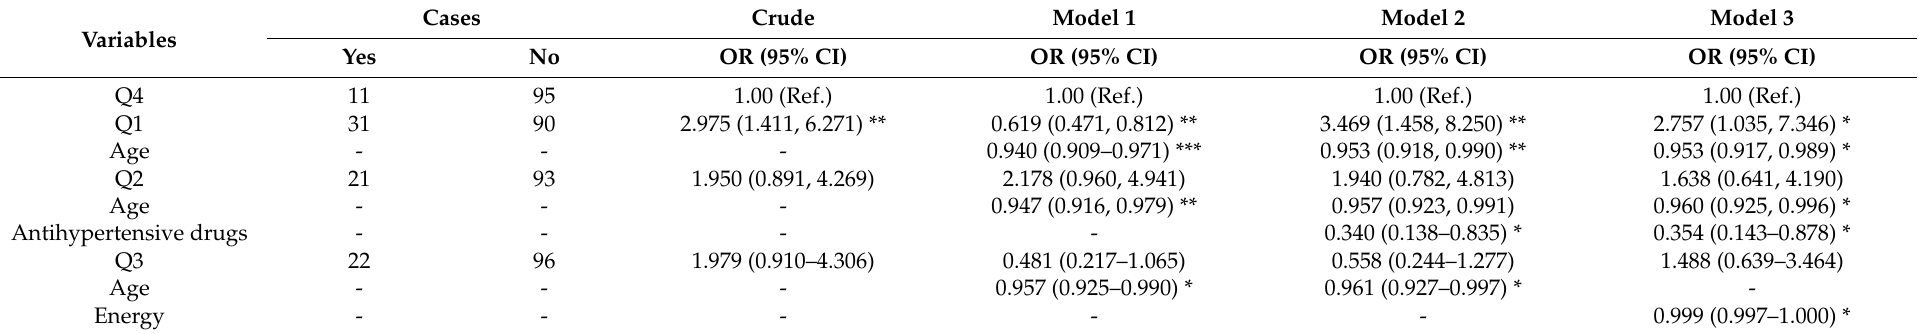
Table 6. Odds ratios and 95% confidence intervals for anxiety according to dietary fiber